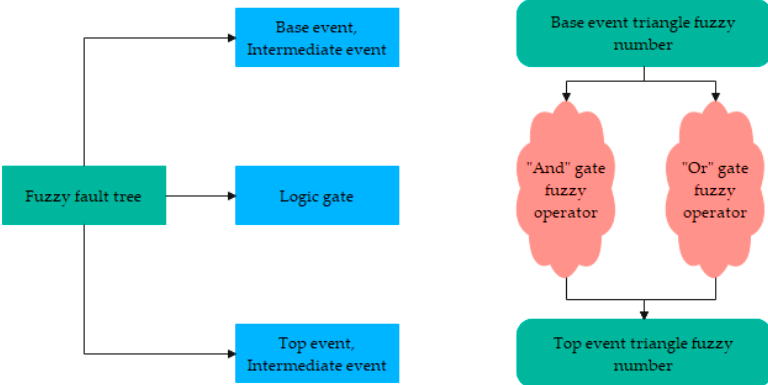
Figure 2. FFTA structure diagram of flywheel.